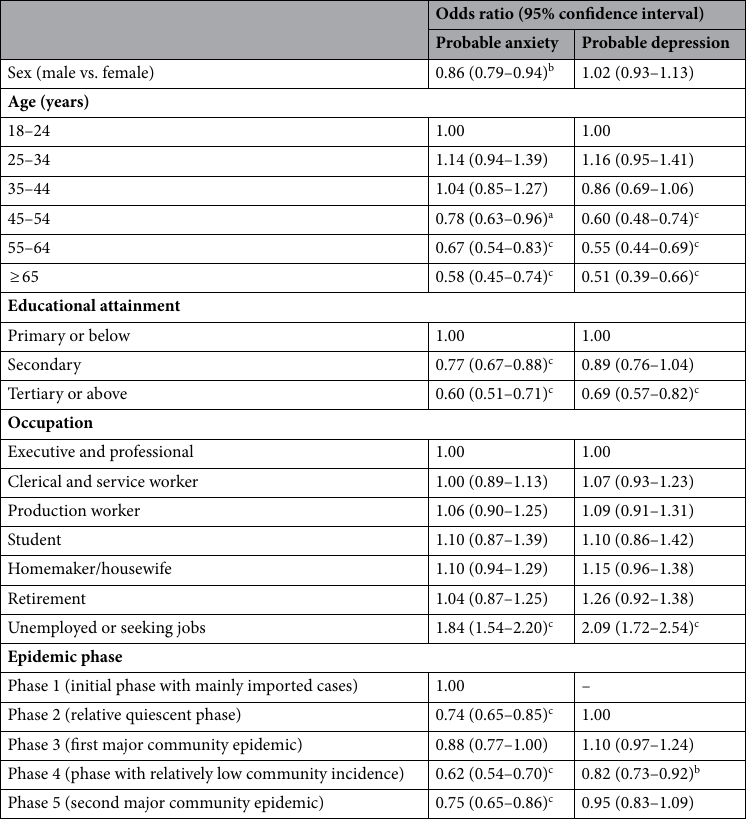
Table 1. Associations of probable anxiety and probable depression with socio-demographics and phases of pandemic. a p < 0.05; b p < 0.01; c p <